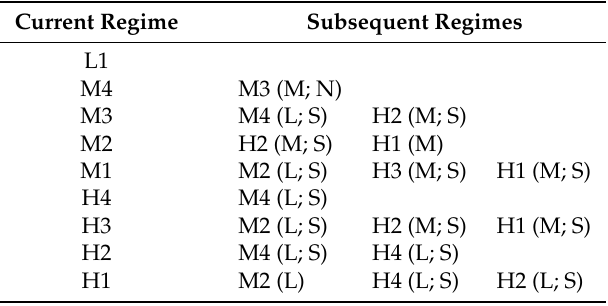
Table 1. The subsequent regimes that a current regime (the leftmost column) transforms into with statistical significance. The associated features of the subsequent regime relative to the current regime are shown in the parenthesis (“L”/“M” represents that the subsequent regime rains less/more relative to the current regime, while “S”/“N” represents that the precipitation center for the subsequent regime is located in south/north of that for the current regime). Current Regime